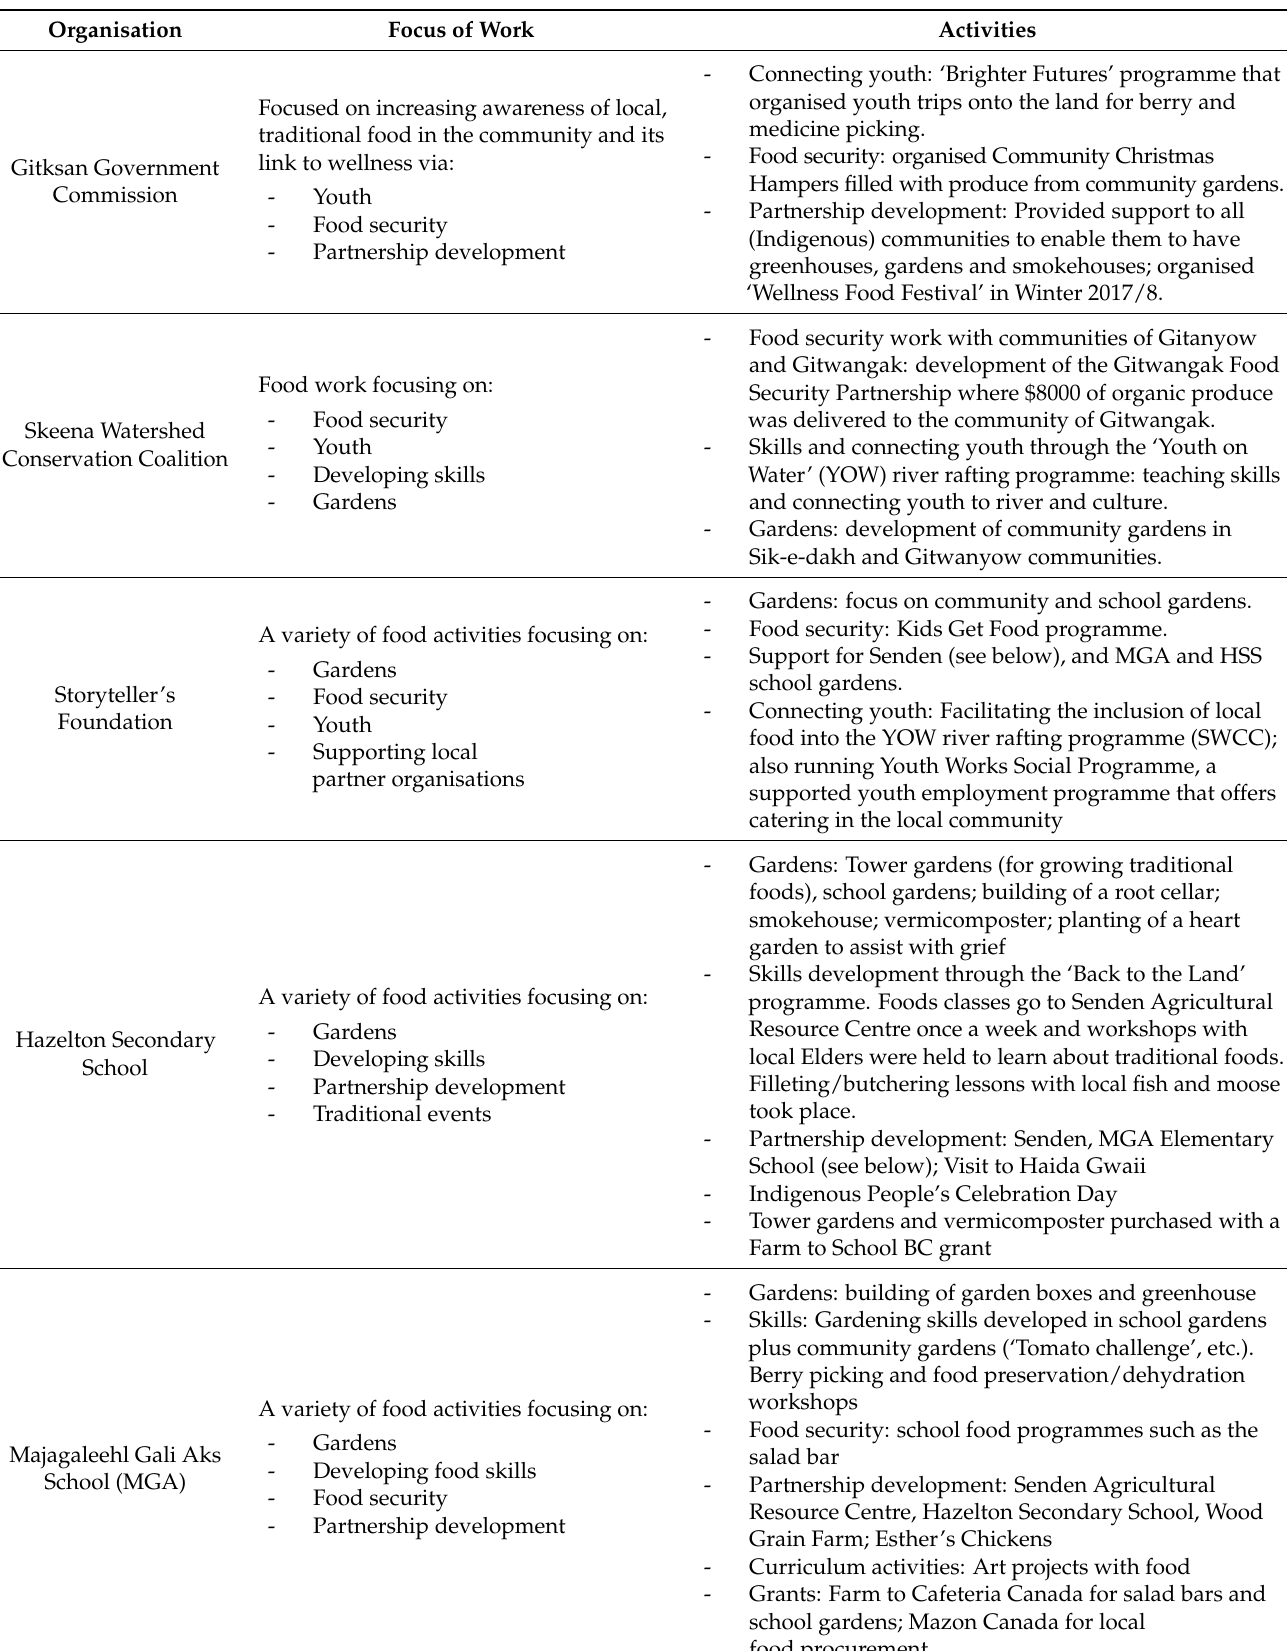
Table 2. Partners in the LC in Hazelton/Upper Skeena, and associated